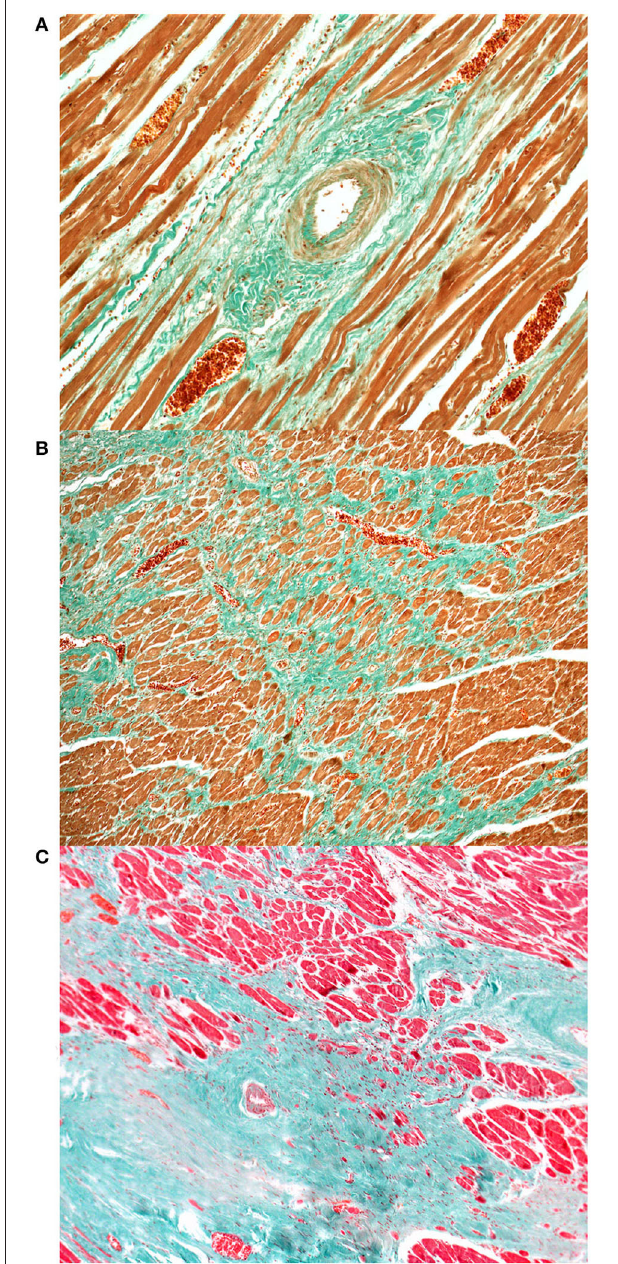
FIGURE 6 | Heart, Eurasian lynx ( Lynx lynx carpathicus ), myocardial fibrosis, Masson’s trichrome stain (A) Mild to moderate increase of the perivascular collagen along with mild to moderate intimal thickening and mild multifocal deposition of collagen between the myofibers; (B) Exuberant collagen is forming a dense web, entrapping, compressing and replacing several myofibers; (C) Islands of collagen bridging from the perivascular areas to the interstitium and replacing large numbers of